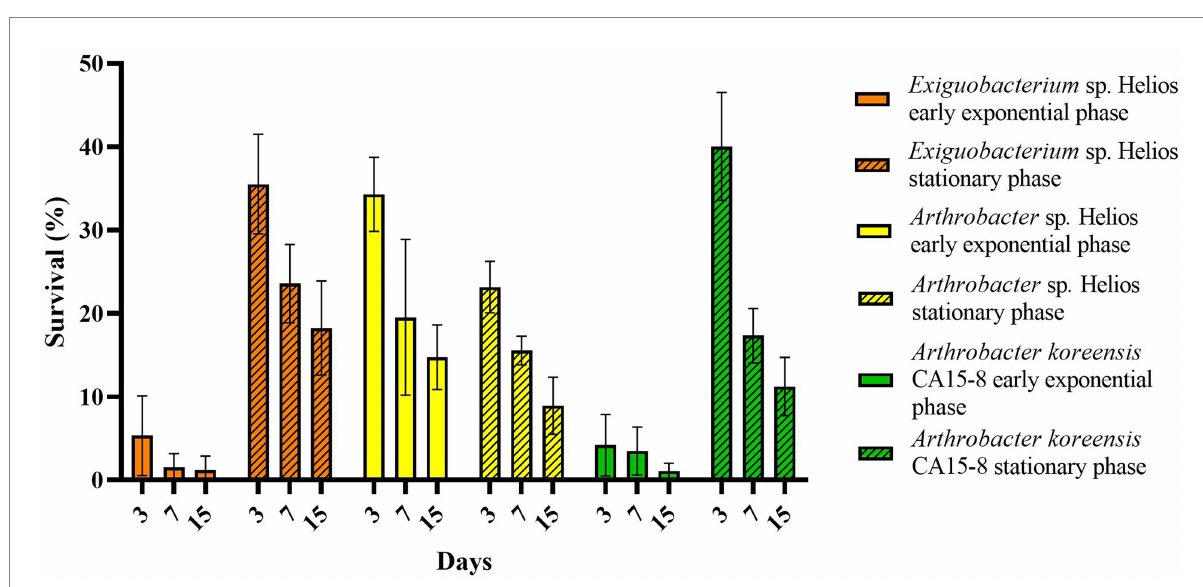
FIGURE 3 Desiccation resistance of Arthrobacter sp. Helios, A. koreensis CA15-8 and Exiguobacterium sp. Helios at exponential and stationary growth